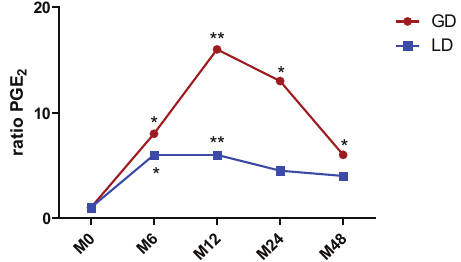
FIGURE 4 - PGE ratio from synovial fluid observed at 0, 6, 12, 24 and 2 48 hours after arthroscopy. *p<0.05 and **p<0.01 in comparison to M0 and M12.